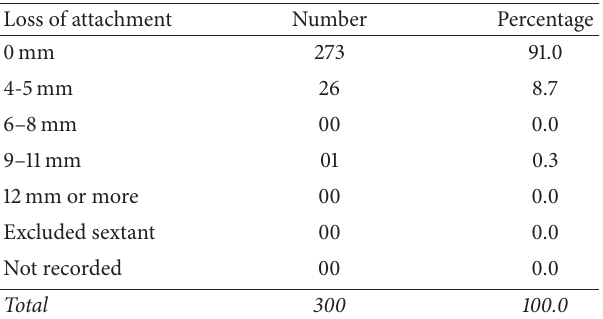
Table 3: Mean number of permanent teeth per person according to dentition status code.